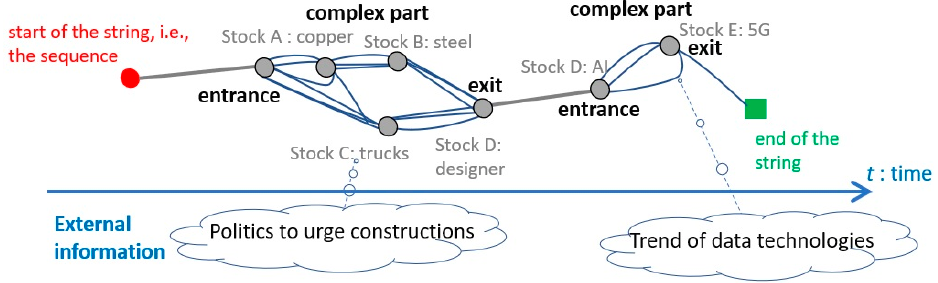
Figure 1. Visualization of a sequence by a string with complex tangled parts.